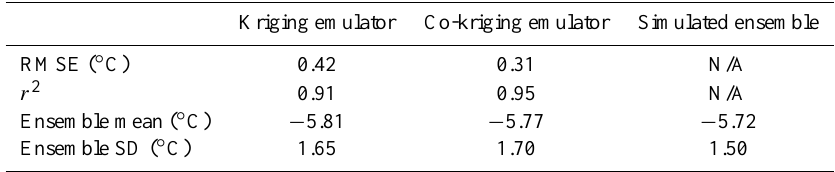
Table 4. Validation results for kriging and co-kriging emulators of PLASIM global mean SAT – SST. The co-kriging emulator uses 70 expensive points and 250 cheap points while the kriging emulator here uses the same 70 expensive points.